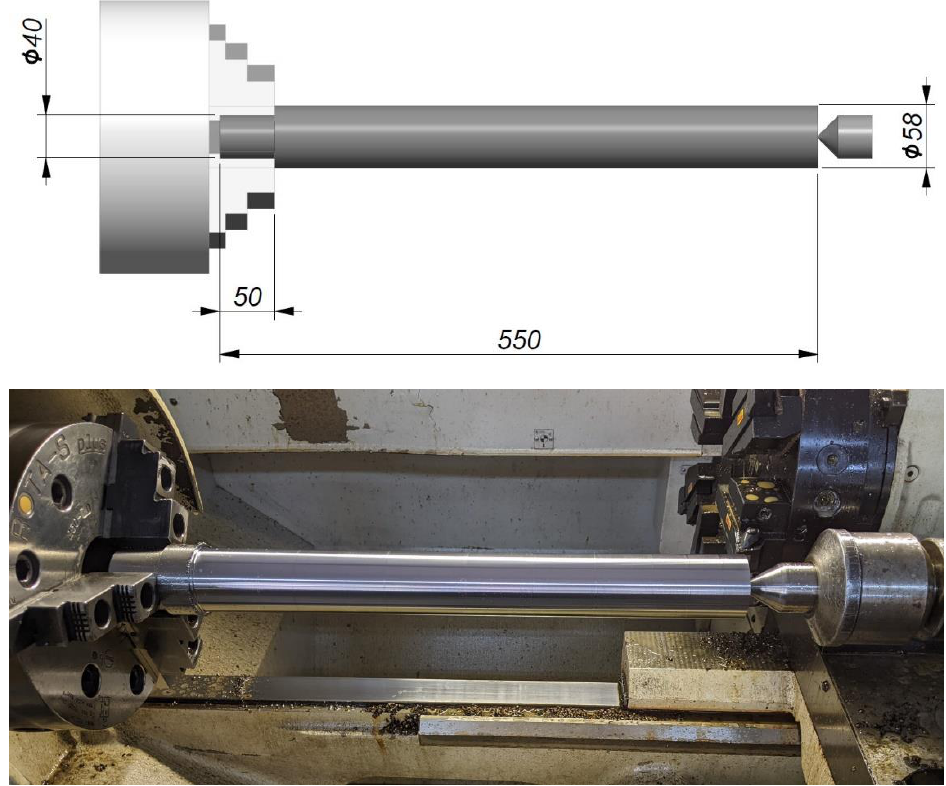
Figure 2. The workpiece geometry and the way of mounting (clamping and supporting). The dimensions shown in the figure are given in mm.